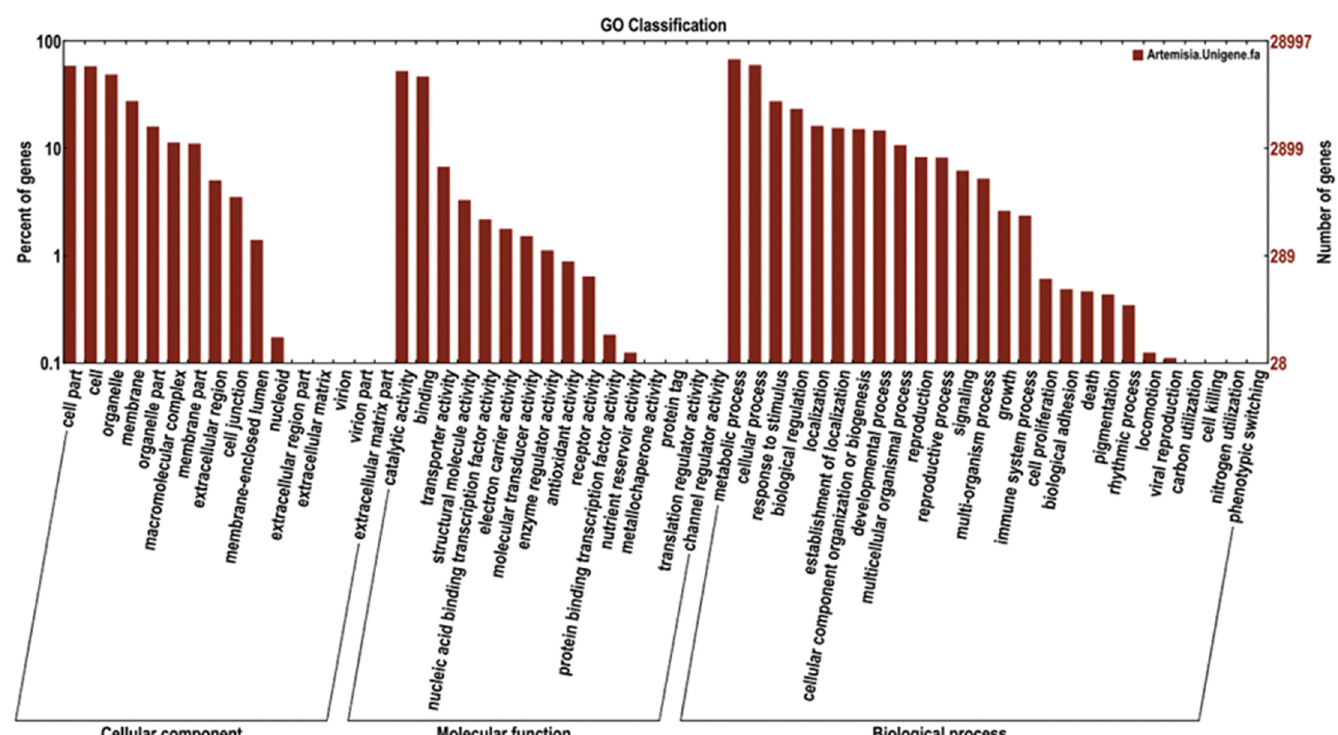
Fig 4. Clusters of Orthologous Group